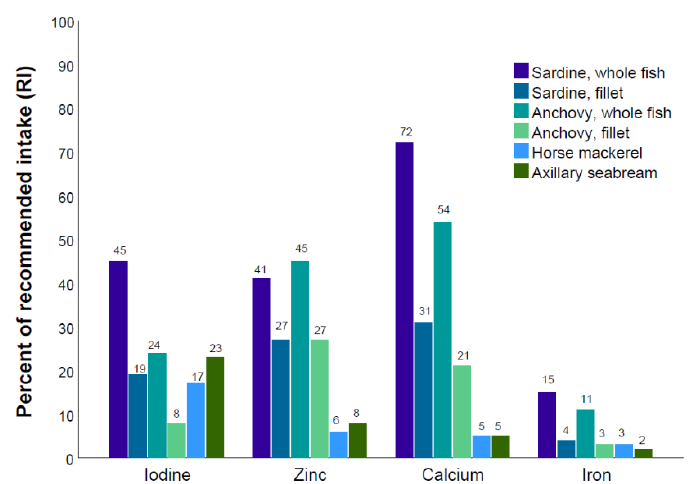
Figure 1. Percent of recommended intake of selected minerals and trace elements for 100 g of sardine (whole fish and fillet), anchovy (whole fish and fillet), horse mackerel, and axillary seabream. Recommended Nutrient Intake (RNI) values from WHO are used (WHO, 1998).